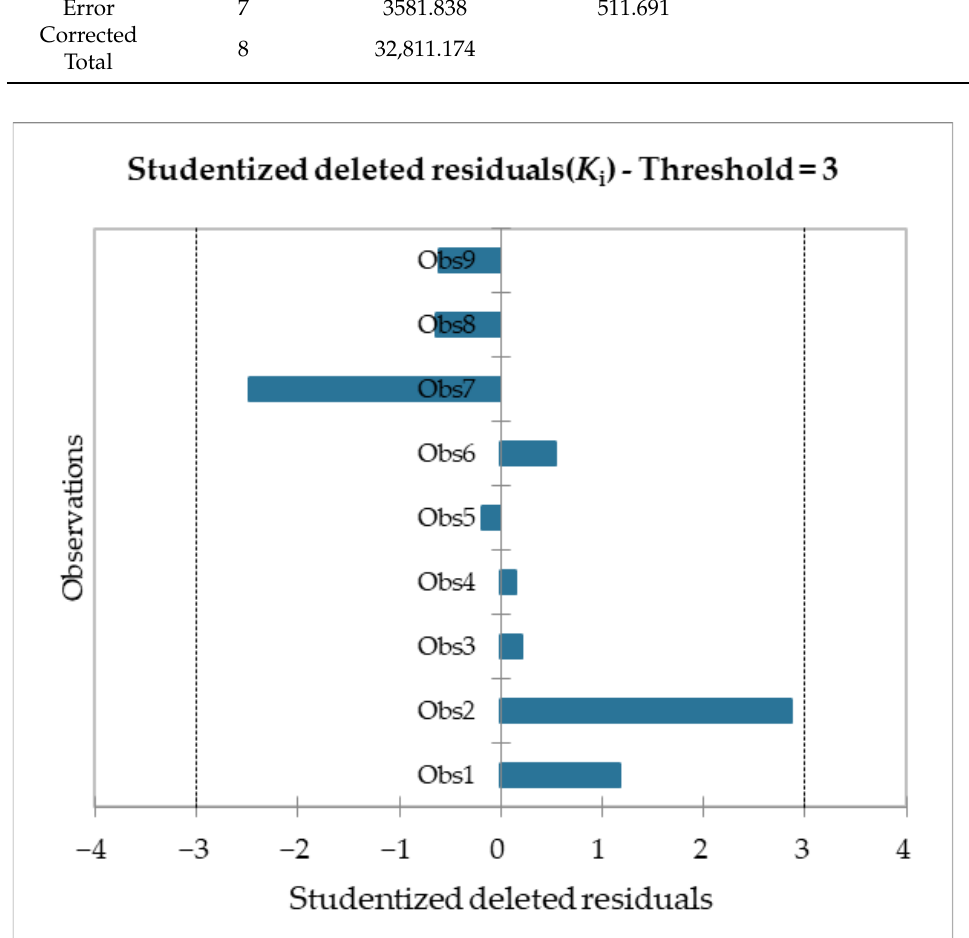
Table 6. Variance table of F max model. Pr: p -value for F statistics. Source